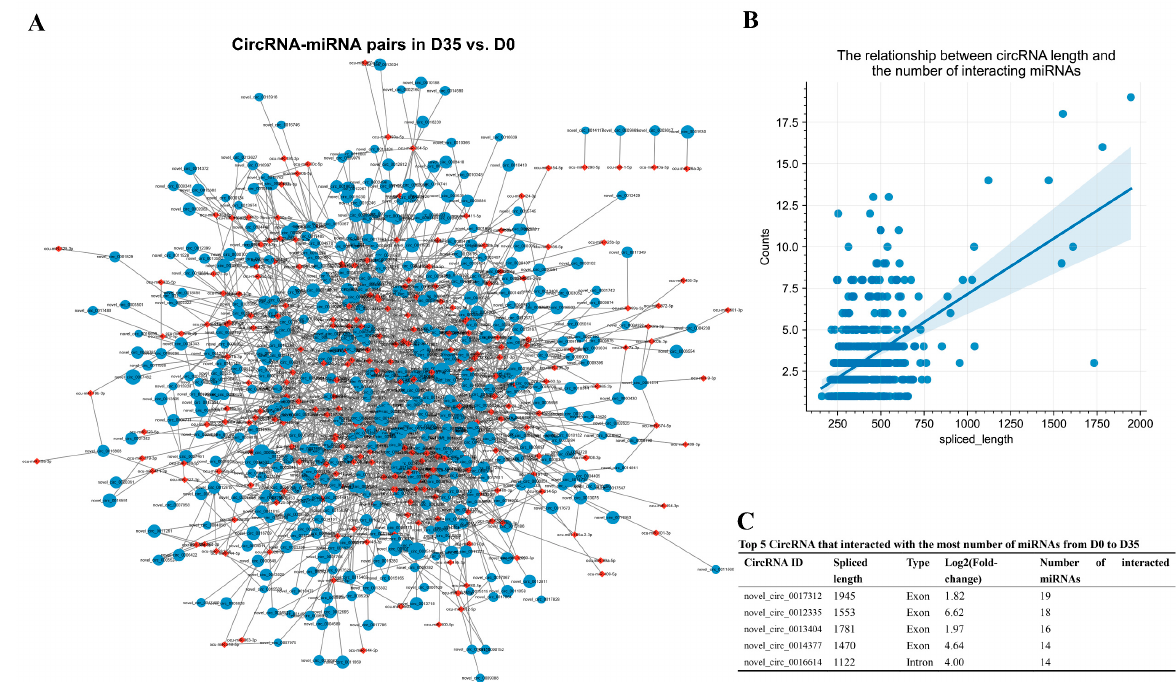
Figure 6. Prediction of putative circRNA–miRNA interaction pairs from D0 to D35. ( A ) Prediction of putative circRNA–miRNA interaction pairs from D0 to D35. The blue and red nodes indicate the circRNAs and miRNAs, respectively. The sizes of blue nodes indicate the values of |log2(fold- change)|. ( B ) The relationship between circRNA lengths and numbers of interacted miRNAs from D0 to D35. ( C ) The top 5 circRNAs that interact with the highest numbers of miRNAs were shown.